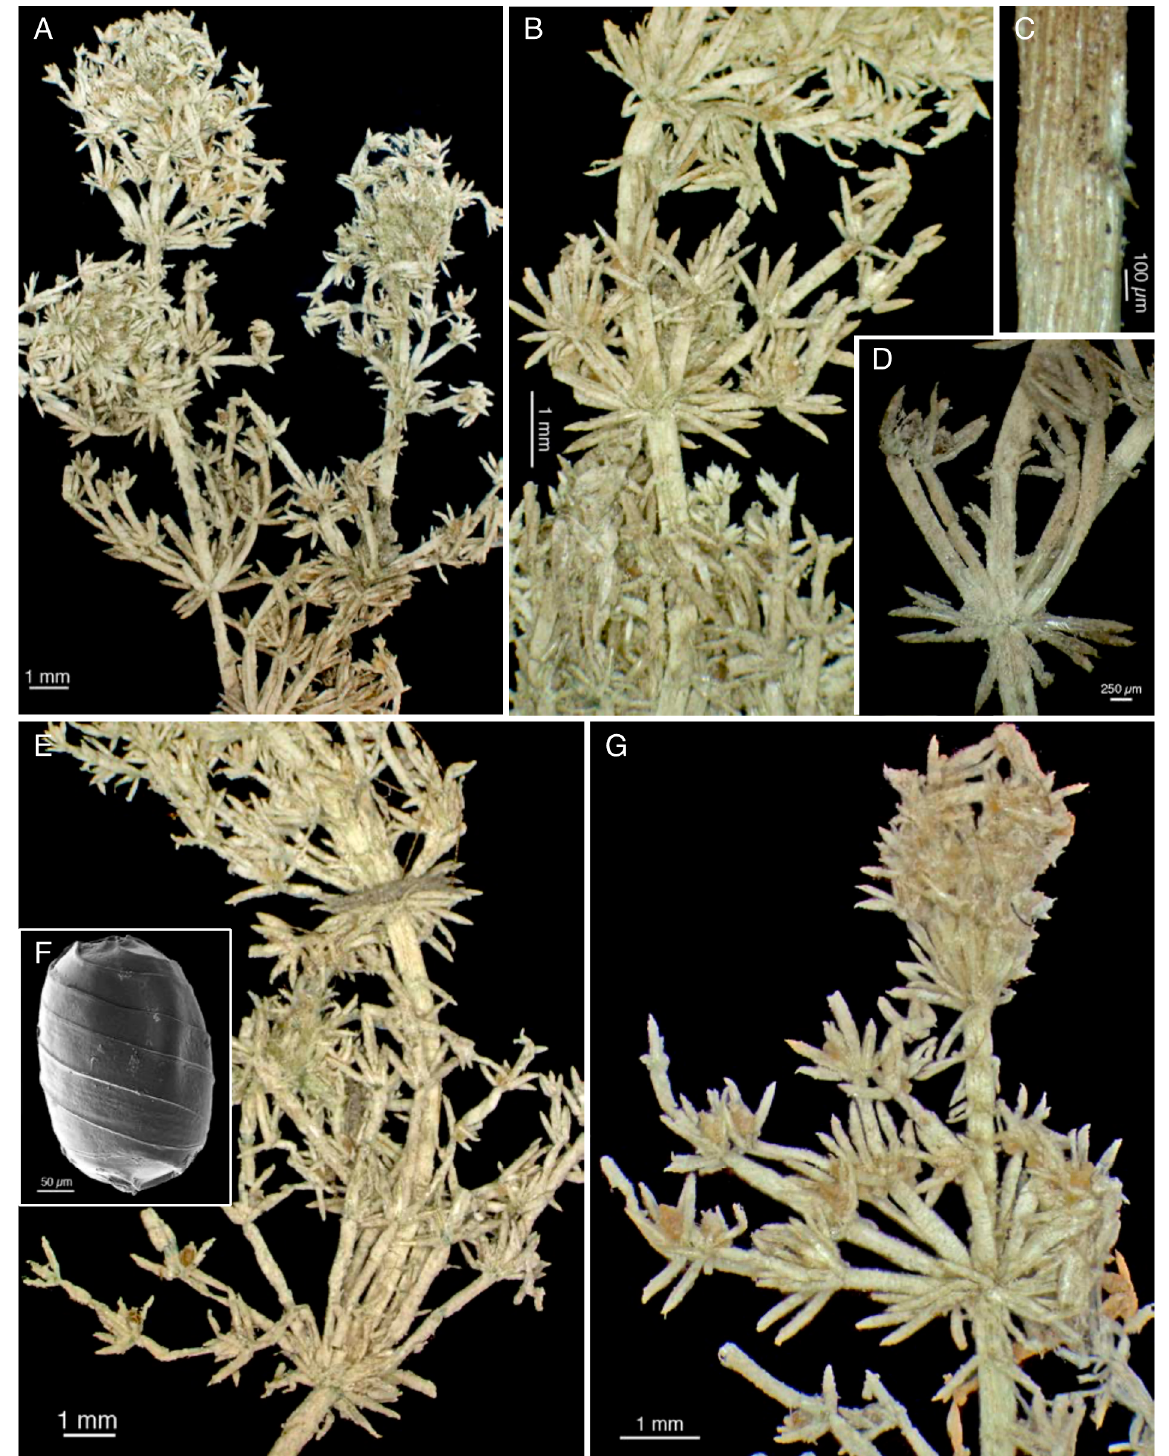
Figure 9. Morphologies of the portions removed from the specimens collected by Ferrari from S. Anna. (1 October 1886). ( A – D ) From the MOD specimen; ( C ) Details of the cortex; ( D ) Details of the stipulodes; ( E , F ) From the TO specimen (N. 3); ( G ) From the PAD